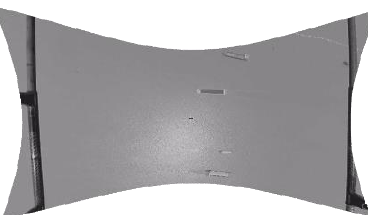
Figure 6. The Rectified Image.